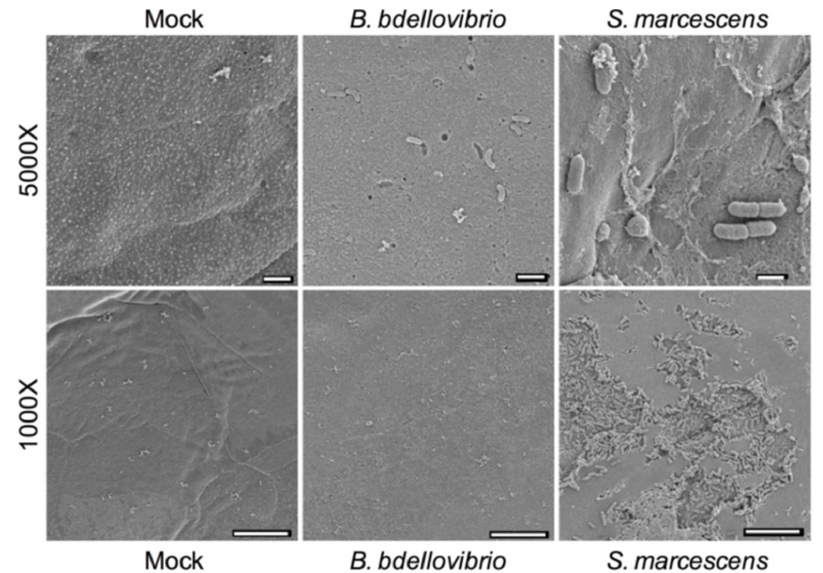
Figure 1. SEM micrographs of porcine corneal surfaces exposed to bacteria for 3 h ex vivo. Represen- tative images are shown. Top row bars, 1 µ m. Bottom row bars, 10 µ m. Both B. Bdellovibrio strain 109J and S. marcescens strain K904 could adhere to the corneal surface, but S. marcescens was associated with damage to the